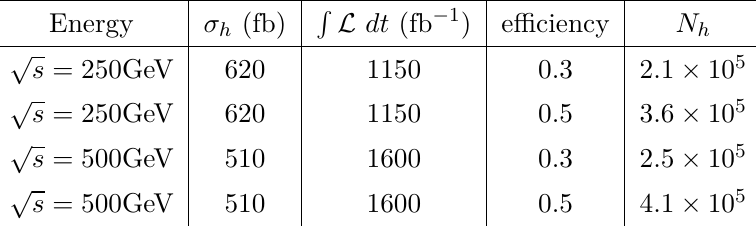
Table 1 . Expected number of produced Higgs bosons.